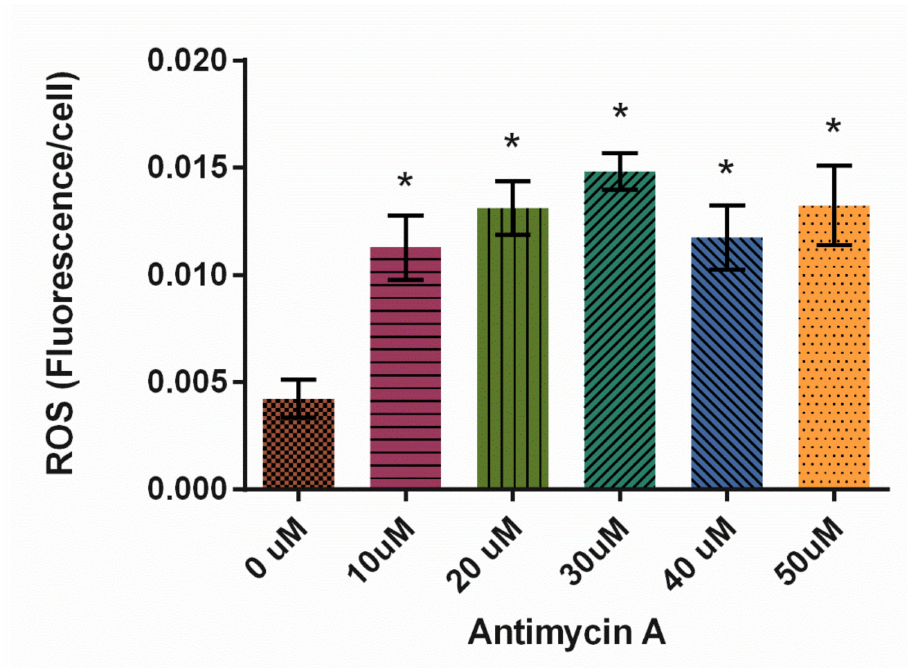
Figure 8. Effect of Antimycin A on average reactive oxygen species (ROS) levels in D. discoideum ± SE ( N = 6). AMA significantly increased ROS levels compared to control, as indicated by * ( p < 0.0001).